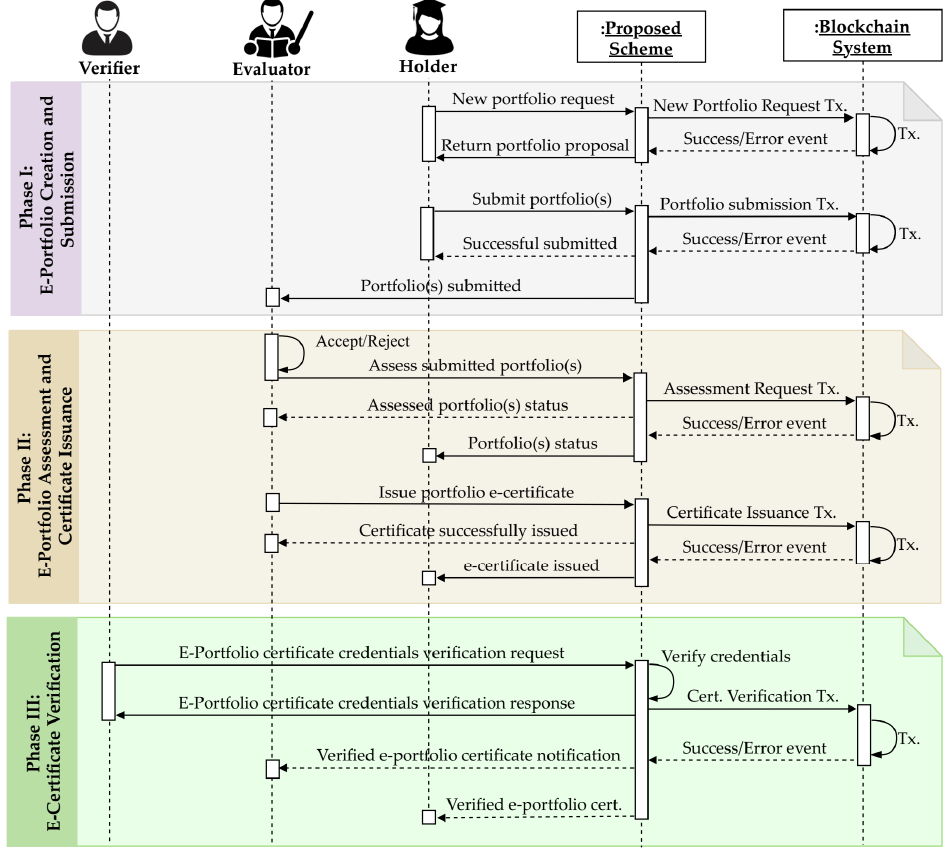
Figure 5. Operational working sequence diagram of the proposed scheme